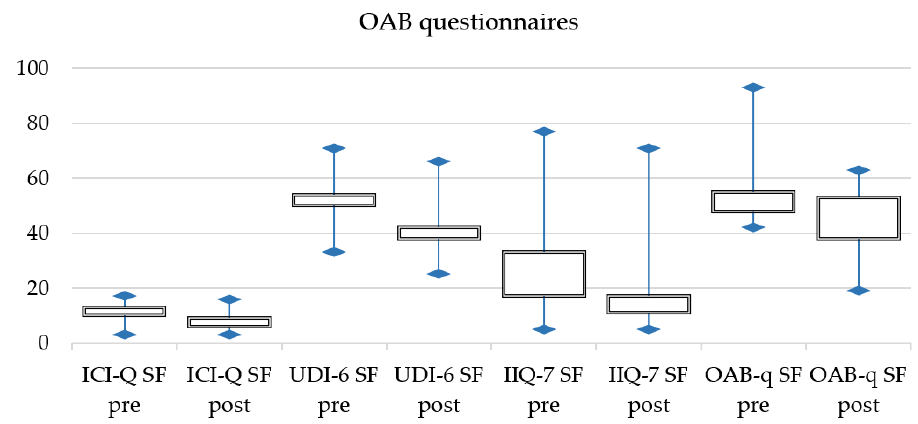
Figure 2. OAB changes in patients reported outcomes.